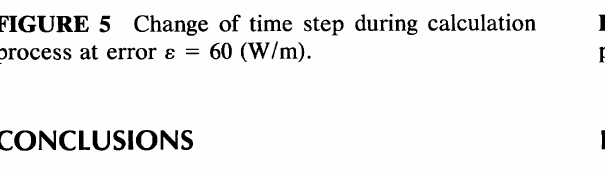
FIGURE 7 Change of time step during calculation process at error e = 120